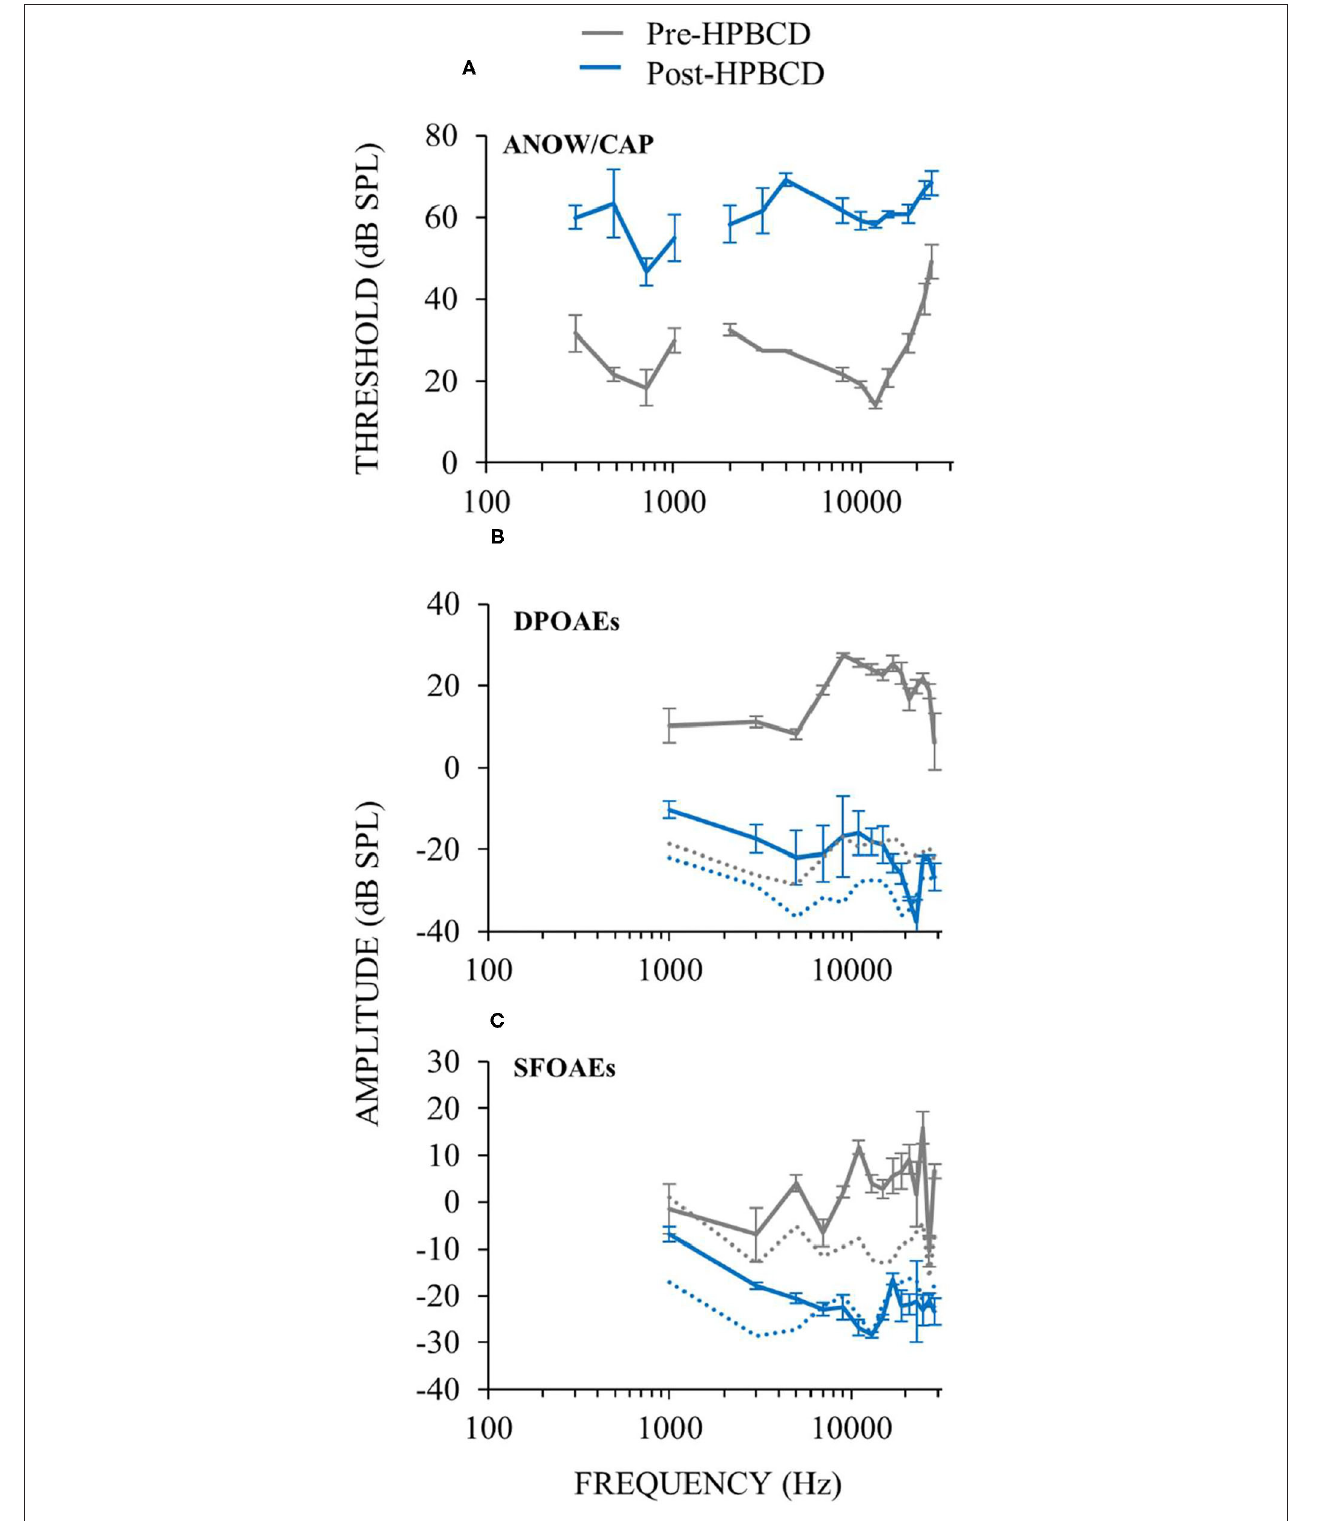
FIGURE 8 | Cochlear function measurements from before (gray) and after (blue) cochlear perfusion with HPBCD in artificial perilymph. Data are averages from three animals. Error bars are one standard error of the mean. HPBCD elevated hearing thresholds (A) , decreased DPOAEs (B) and decreased SFOAEs (C) . OAE noise floors (dotted lines in B,C ) for pre-HPBCD measurements were higher than post-HPBCD treatment because a paralytic was administered after the pre-HPBCD measurements.